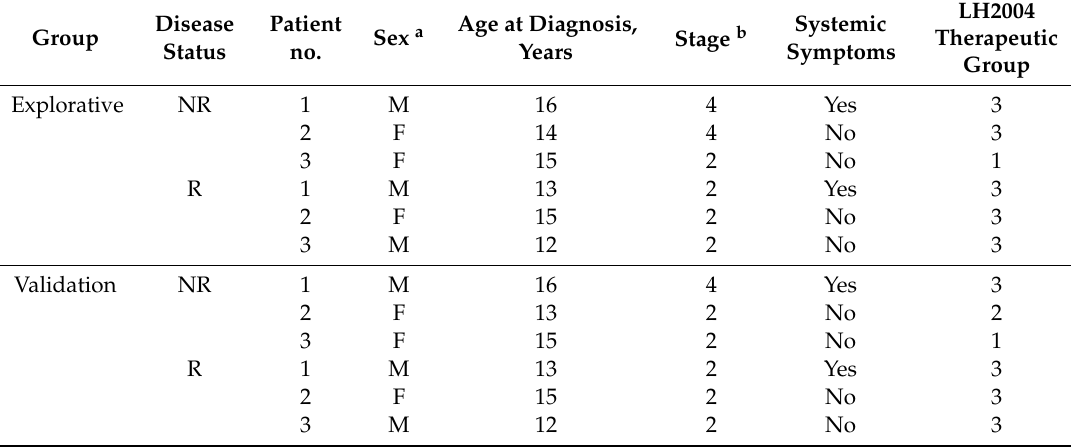
Table 1. Clinicopathological characteristics of patients with pediatric Hodgkin lymphoma (all